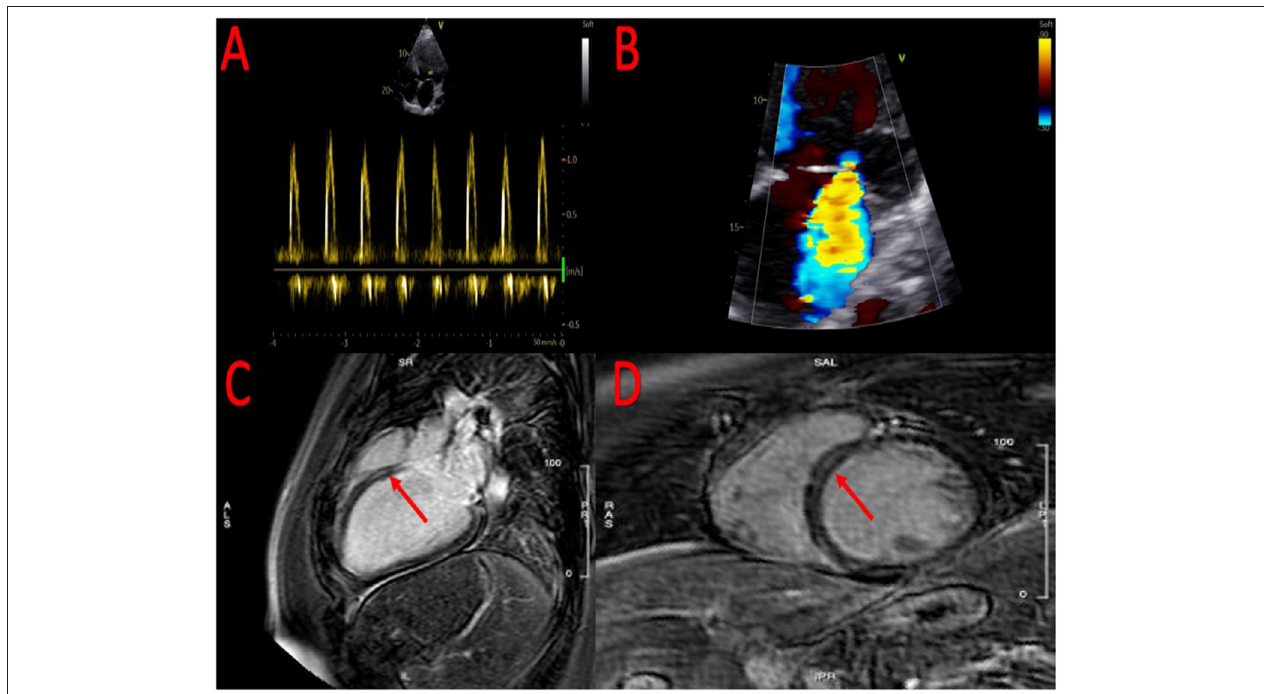
FIGURE 1 | Echocardiographic evidence of severe diastolic dysfunction (A) and severe mitral regurgitation (B) . At cardiac magnetic resonance, evidence of small area of fibrosis at the basal level of the interventricular septum (C,D)